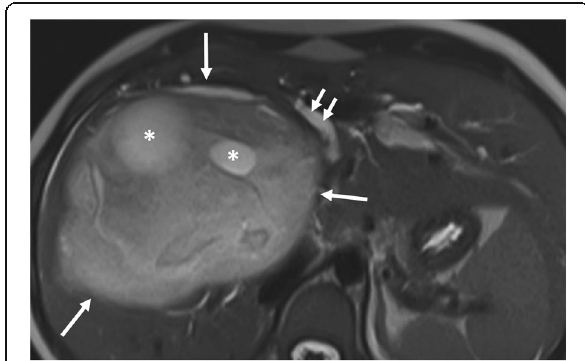
Fig 1. A 16-year-old girl was admitted to the emergency department with a 1-week history of pruritus, jaundice, and fever. Axial T2-weighted MR-image shows the imaging findings of intrabiliary rupture of a hydatid cyst (long arrows). Floating membrane within the dilated bile duct (short white arrows) and daughter cysts (asterisks) are also noted. Serological tests for E . granulosus were